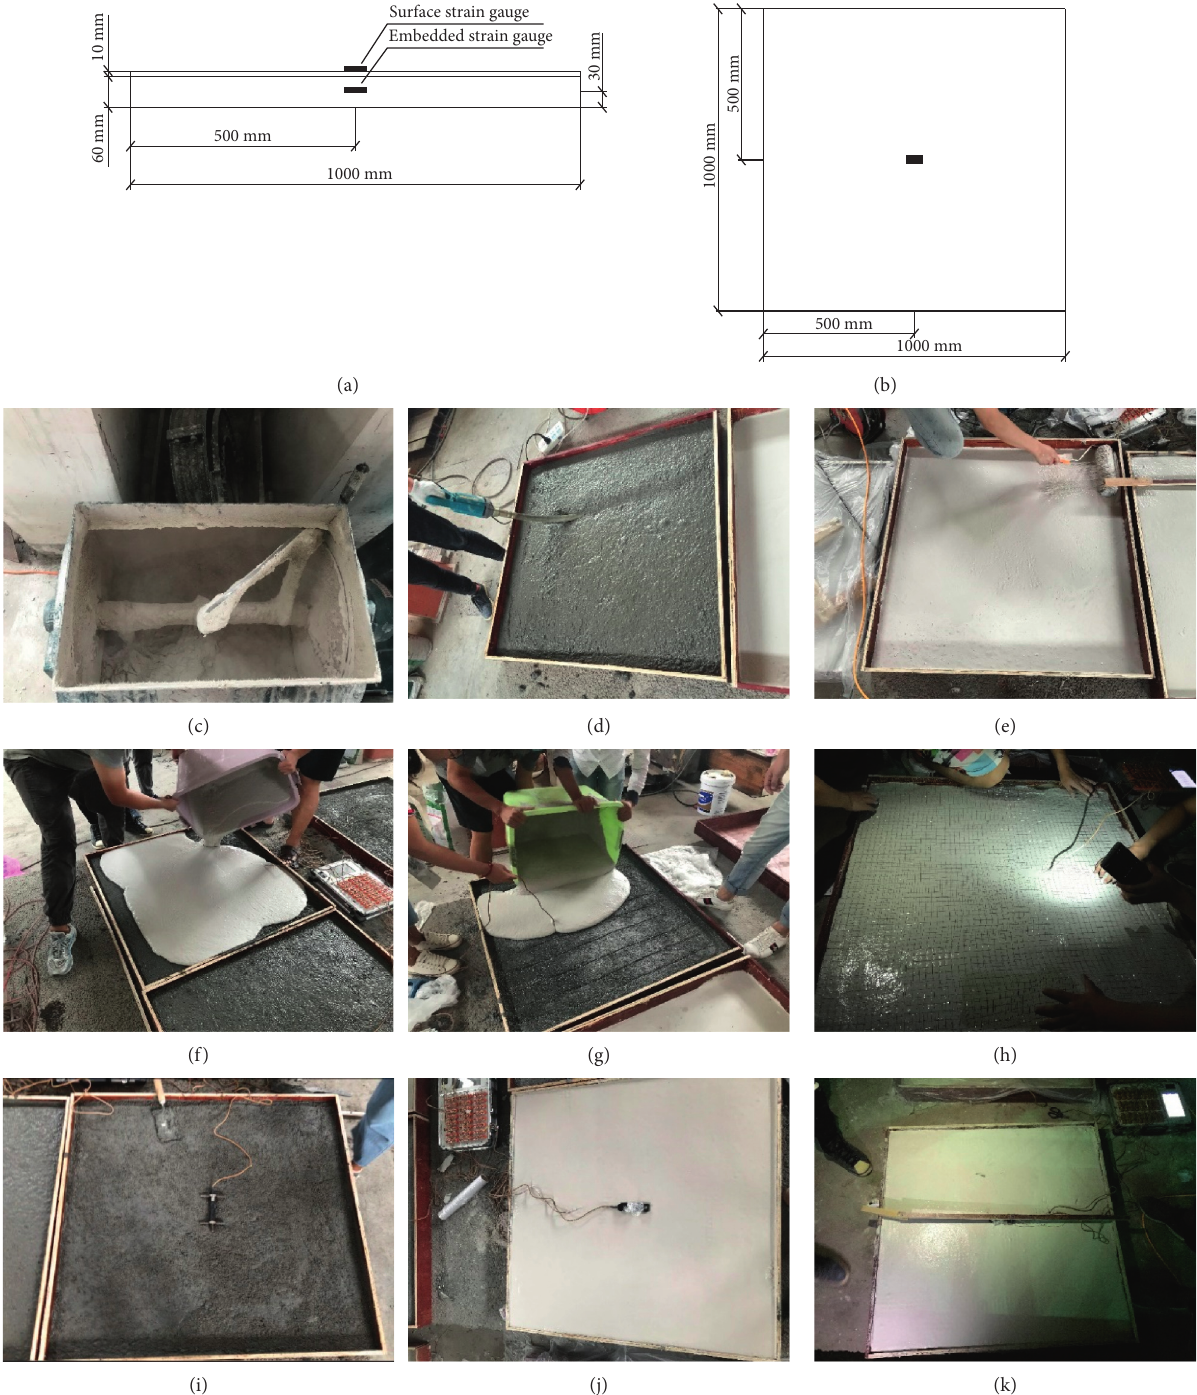
Figure 5: Composite panel production process. (a) Location of surface strain gauge. (b) Location of embedded strain gauge. (c) Mixing GRC. (d) Vibration rod vibration. (e) Roller brushing. (f) Smooth connection. (g) Rough connection. (h) Laying steel mesh connection. (i) Embedded strain gauge. (j) Surface strain gauge. (k) Fixed surface strain